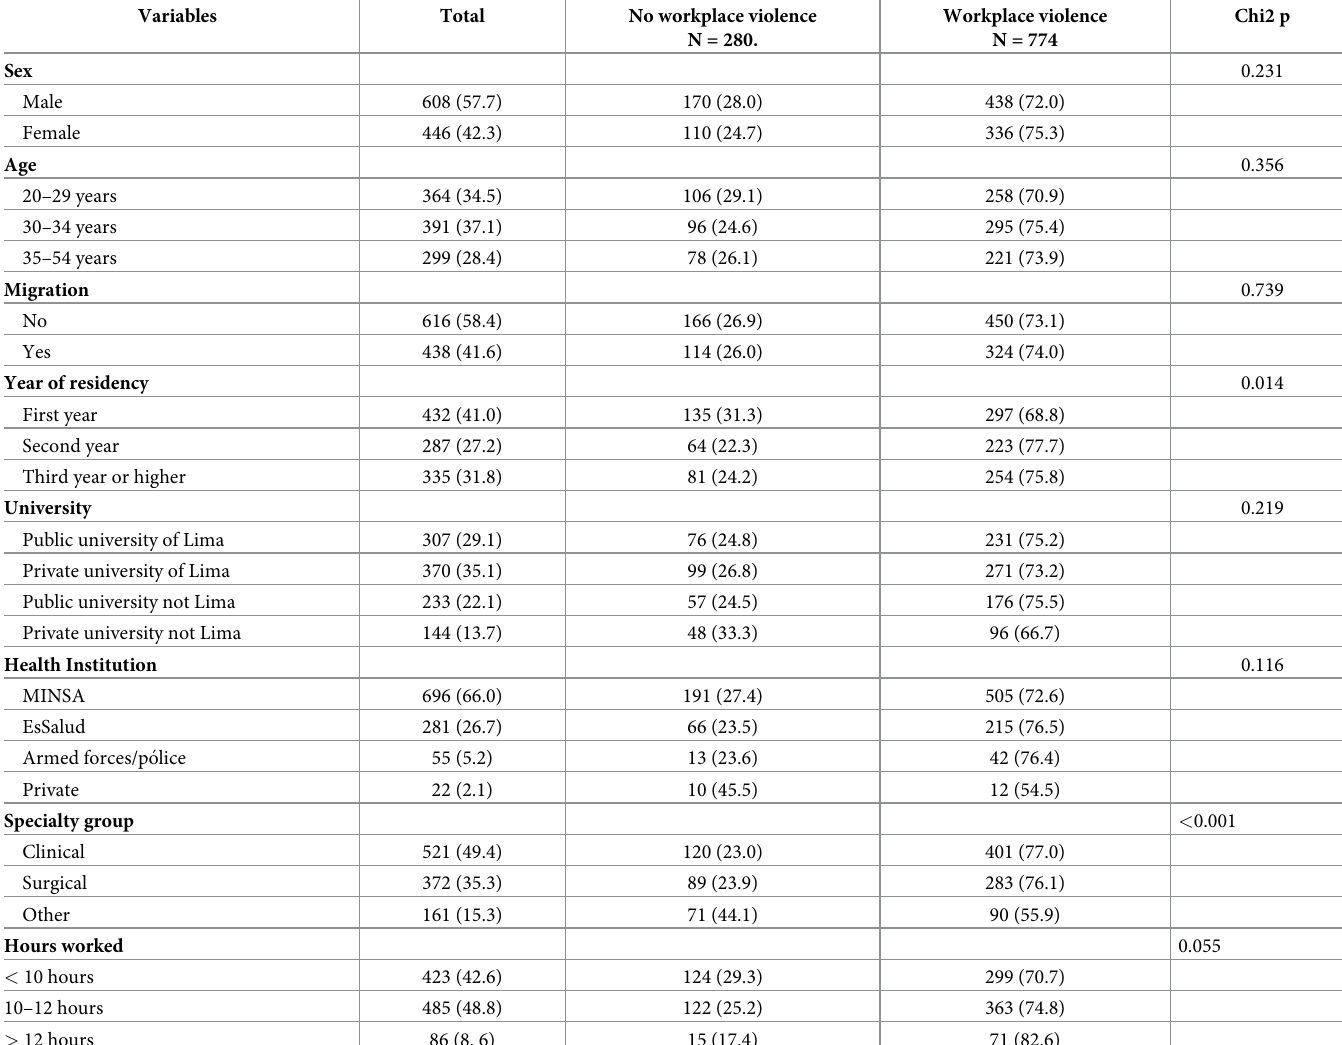
Table 2. Characteristics of the population according to having suffered workplace violence (n = 1054).